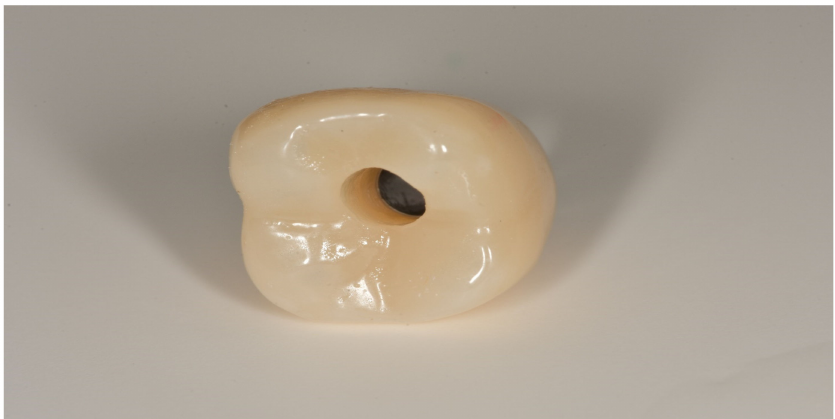
Figure 2. Occlusal view of the monolithic CAD / CAM lithium disilicate crown with the screw access